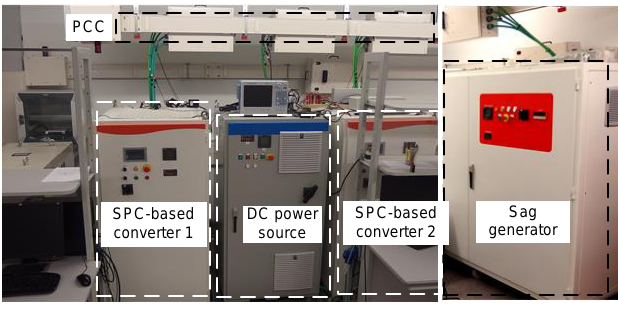
Figure 13. Laboratory view of the asymmetrical grid fault experimental setup.